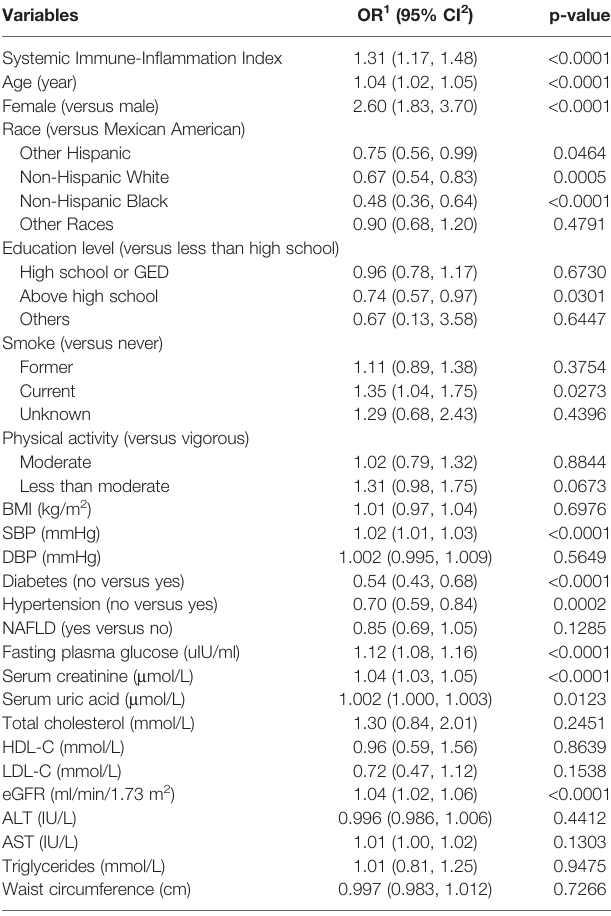
TABLE 3 | Multivariate logistic regression models of albuminuria.